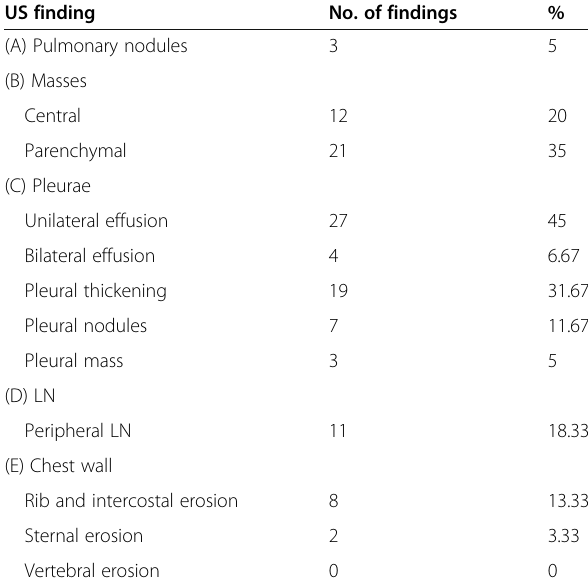
Table 4 Ultrasound findings US finding